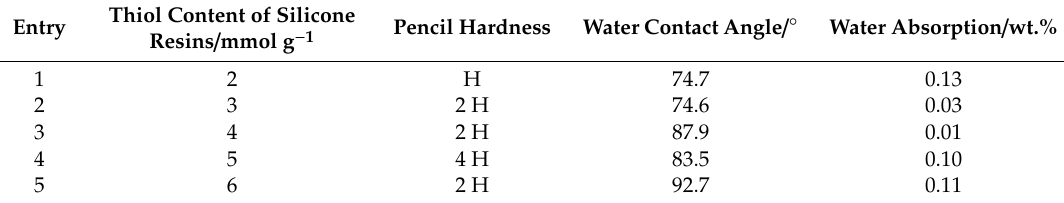
Table 3. Impact of thiol content of silicone resin.